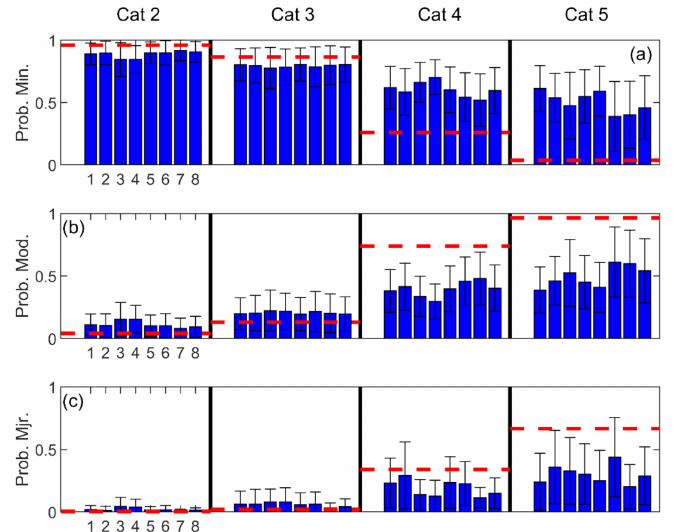
Figure 12. Log-normal predicted and observed fractions of damage classification by storm category (vertical columns). Each subplot corresponds to a damage classification: ( a ) Minimal; ( b ) Moderate; ( c ) Major. Vertical bars correspond to EDP case (1 to 8 in each box), whiskers are standard deviation in predicted probabilities for storms within the Category. Dashed red horizontal bar is the fraction of observed classifications corresponding to the appropriate storm